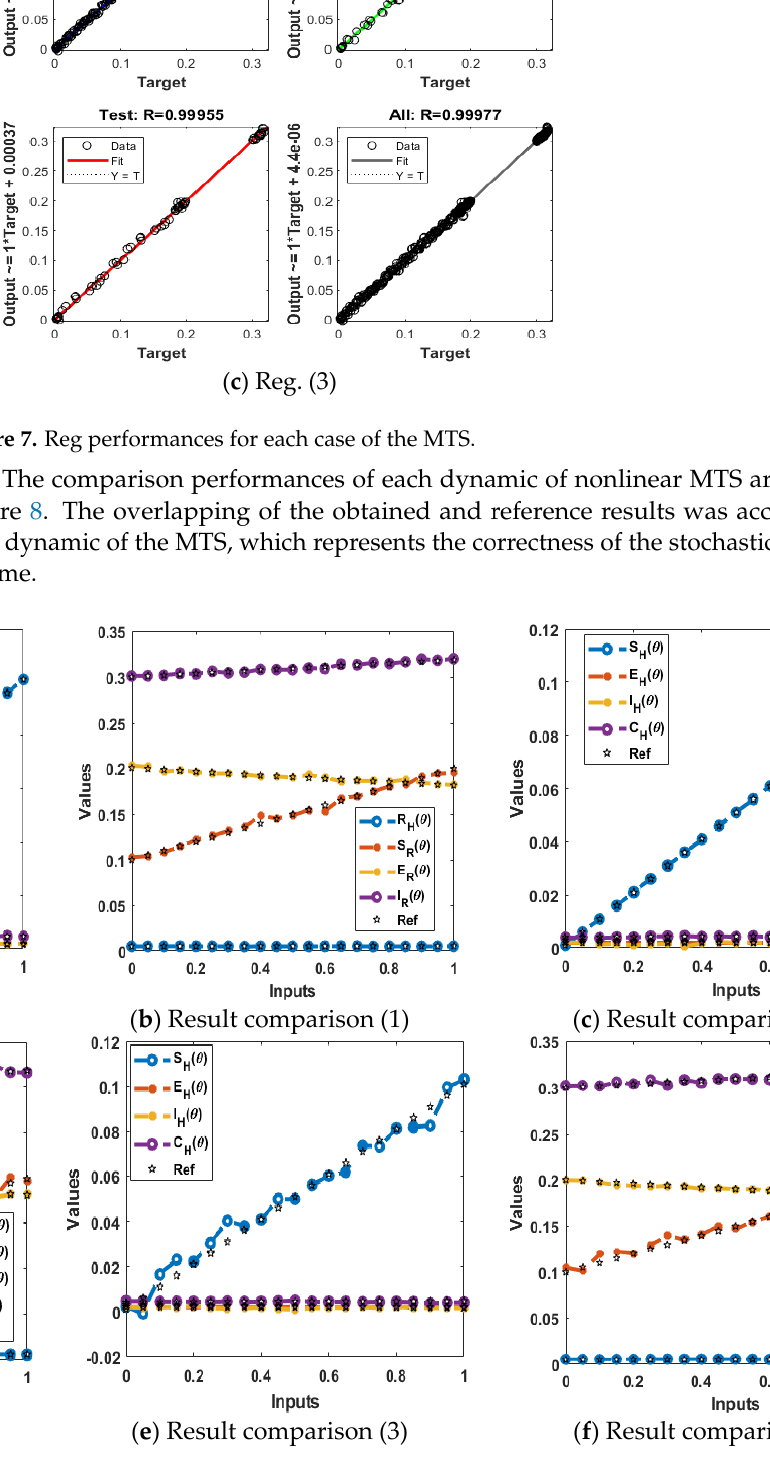
Figure 8. Result comparisons for each class of the nonlinear dynamics of the MTS.